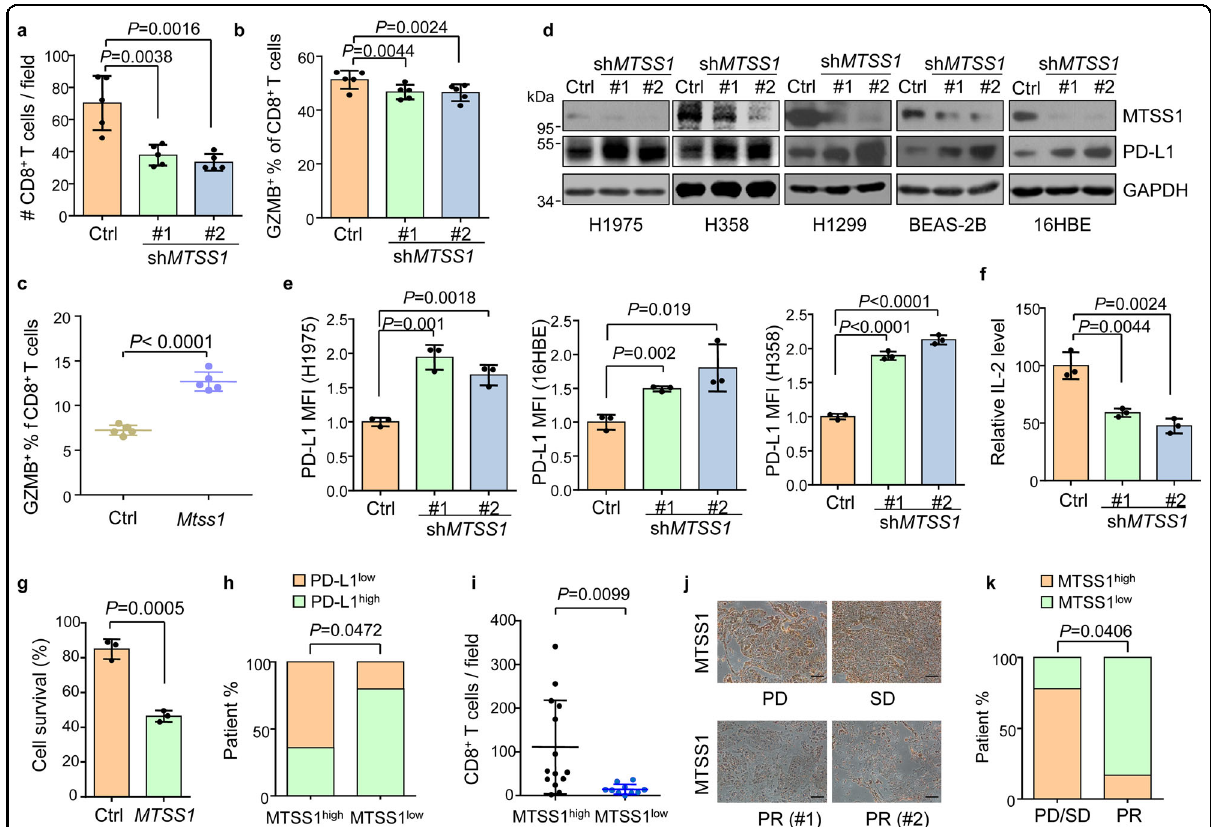
Fig. 2 MTSS1 suppresses PD-L1 protein expression and immune evasion. a , b Quanti fi cation of immunohistochemistry staining of CD8 + T cells ( a ) and GZMB + CD8 + T cells ( b ) in H1975 tumors with or without MTSS1 knockdown in PBMC-humanized NOG mice ( n = 5 per group). c Flow cytometry analysis of GZMB + CD8 + T cells in control and Mtss1 -overexpressing LLC tumor tissues ( n = 5 per group). d MTSS1 and PD-L1 protein levels in the indicated normal lung bronchial and lung cancer cell lines after MTSS1 knockdown. e Cell surface PD-L1 was quanti fi ed by fl ow cytometry mean fl uorescence intensity (MFI) in lung cancer cell lines after MTSS1 knockdown. f IL-2 levels in supernatants of Jurkat cells co-cultured with H1975 with or without MTSS1 knockdown for 24 h. g Survival of H1975 cells with MTSS1 overexpression after co-culturing with activated human T cells. h , i Quanti fi cation of immunohistochemistry staining of PD-L1 ( h ) and CD8 + T cells ( i ) in human LUAD samples with high ( n = 14) and low ( n = 10) MTSS1 expression. j , k Representative images ( j ) and quantitation ( k ) of MTSS1 immunostaining in LUAD patients displaying different responses to anti-PD1/PD-L1 therapy, including partial response (PR, n = 6), progressive disease (PD, n = 1) and stable disease (SD, n = 8). Scale bars, 100 μ m. Data are shown as means ± SD ( a – c , e – g , i ). P values were calculated by a two-tailed t -test ( a – c , e – g , i ), or Fisher ’ s exact test ( h , k